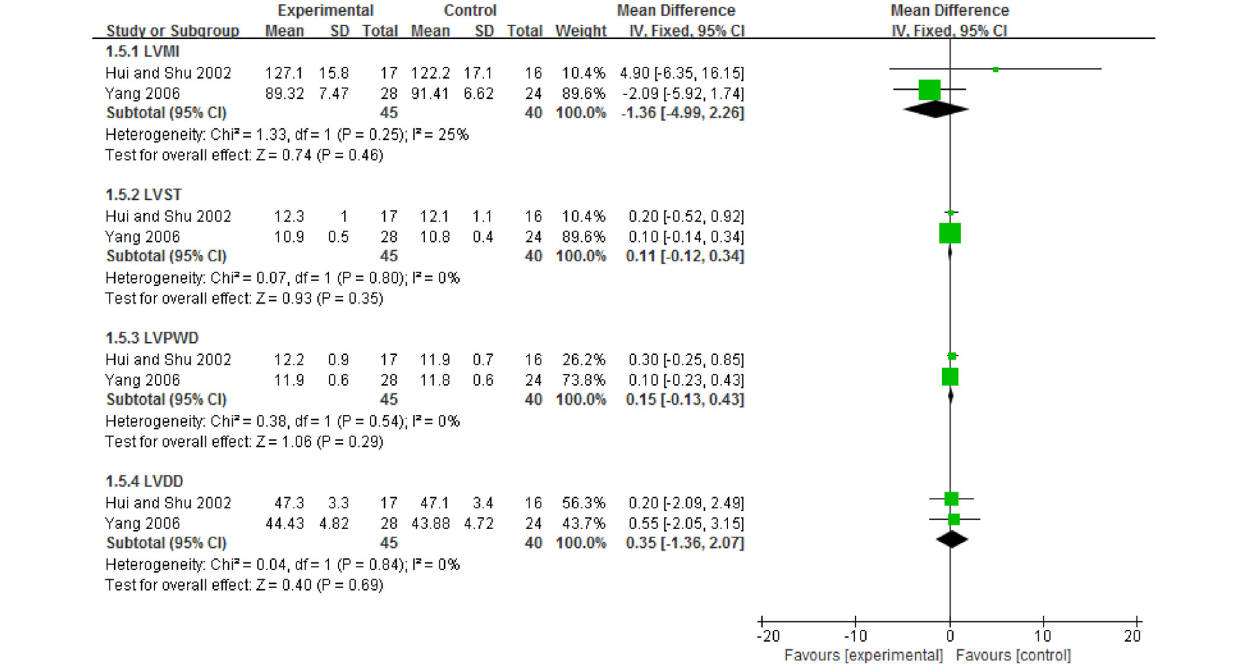
FIGURE 6 | The forest plot of comparison of two groups for the outcome of left ventricular mass.